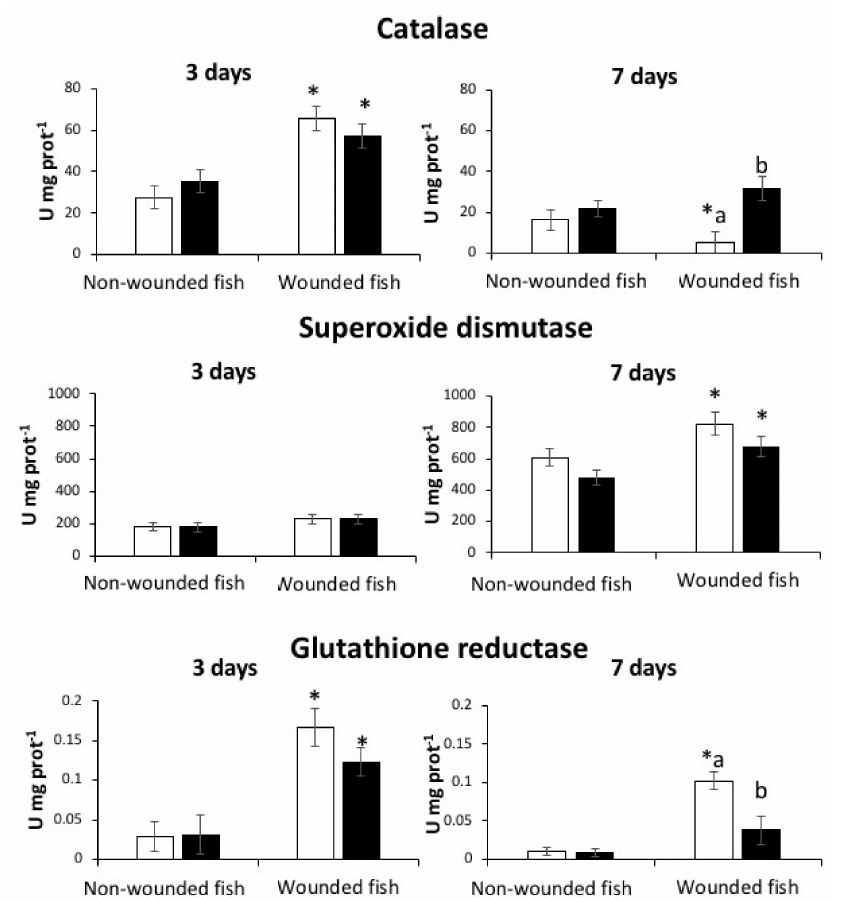
Figure 1. Catalase, superoxide dismutase, and glutathione reductase activities (expressed in units per milligram of proteins) in the wounded and non-wounded flanks at 3 and 7 days post wounding in the control (non-wounded) and wounded fish. Values are presented as mean ± SEM ( n = 5). Differences between the flanks are indicated by different letters; differences between groups (wounded and non-wounded fish) are indicated by asterisks ( p <